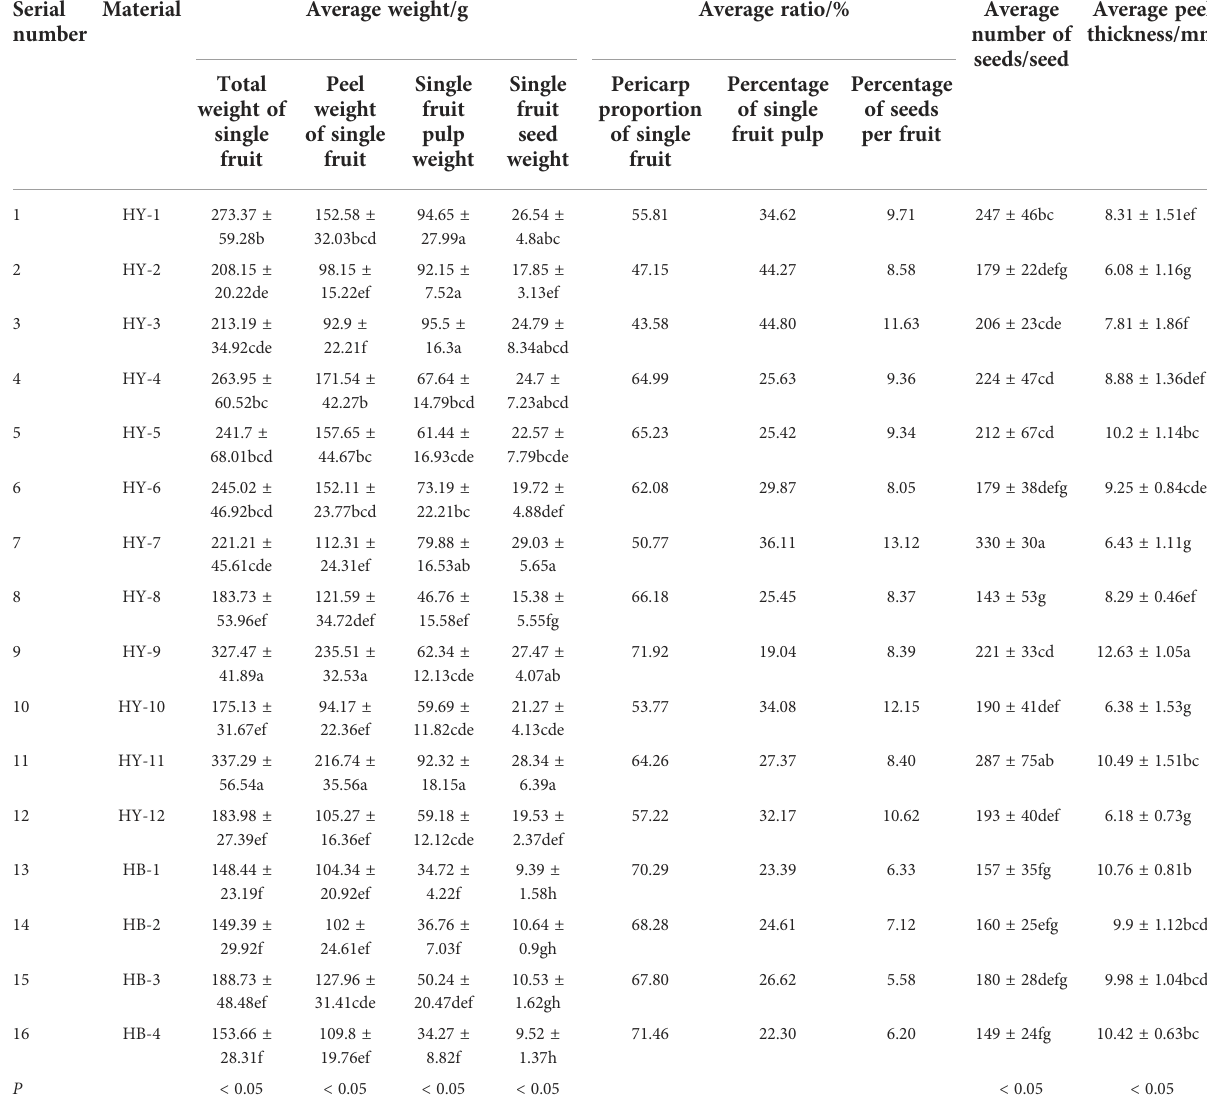
TABLE 2 The components and proportions of different genotypes of A. trifoliata fruit. Serial Material Average weight/g Average ratio/% Average Average peel number number of thickness/mm seeds/seed Total Peel Single Single Pericarp Percentage Percentage weight of weight fruit fruit proportion of single of seeds single of single pulp seed of single fruit pulp per fruit fruit weight weight fruit